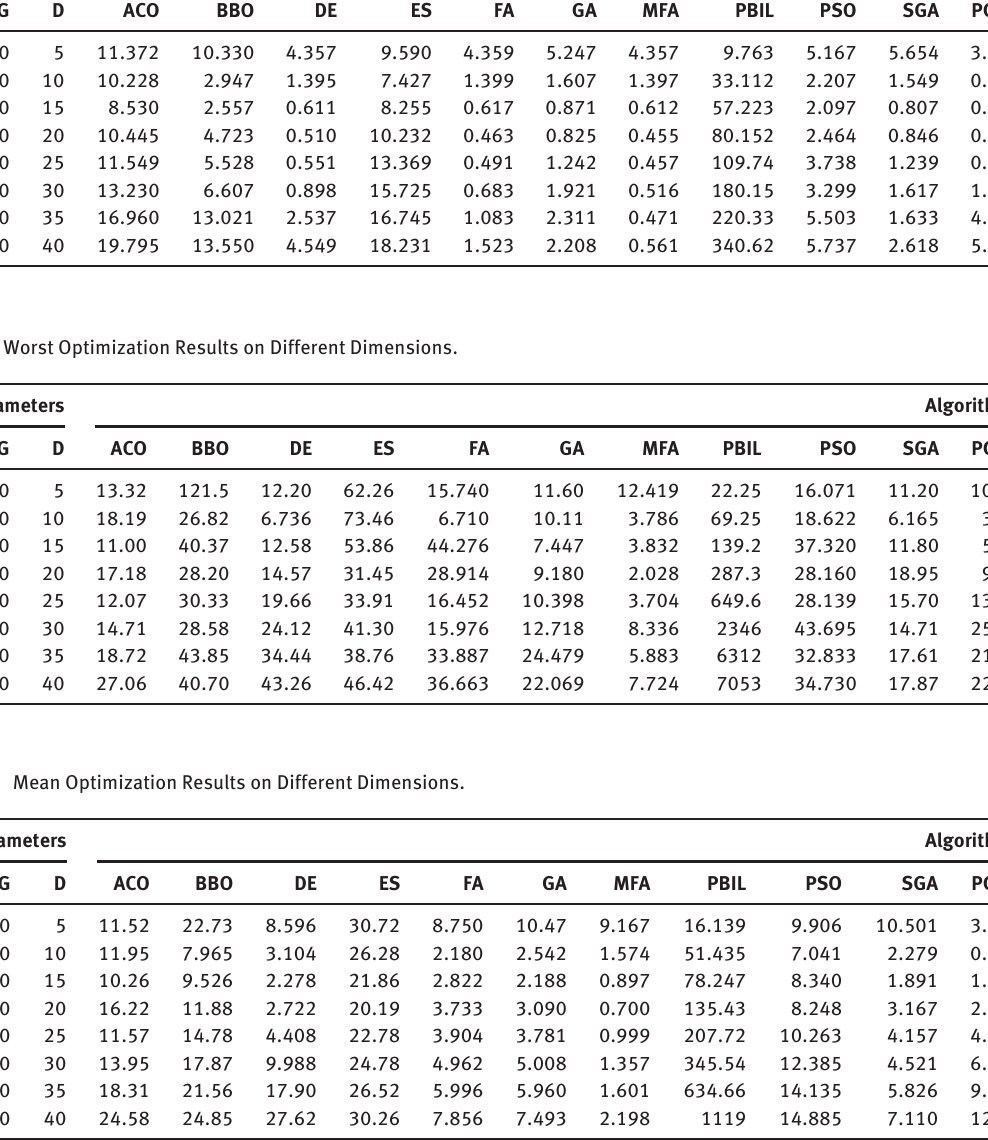
Table 8. Best Optimization Results on Different Dimensions. Para